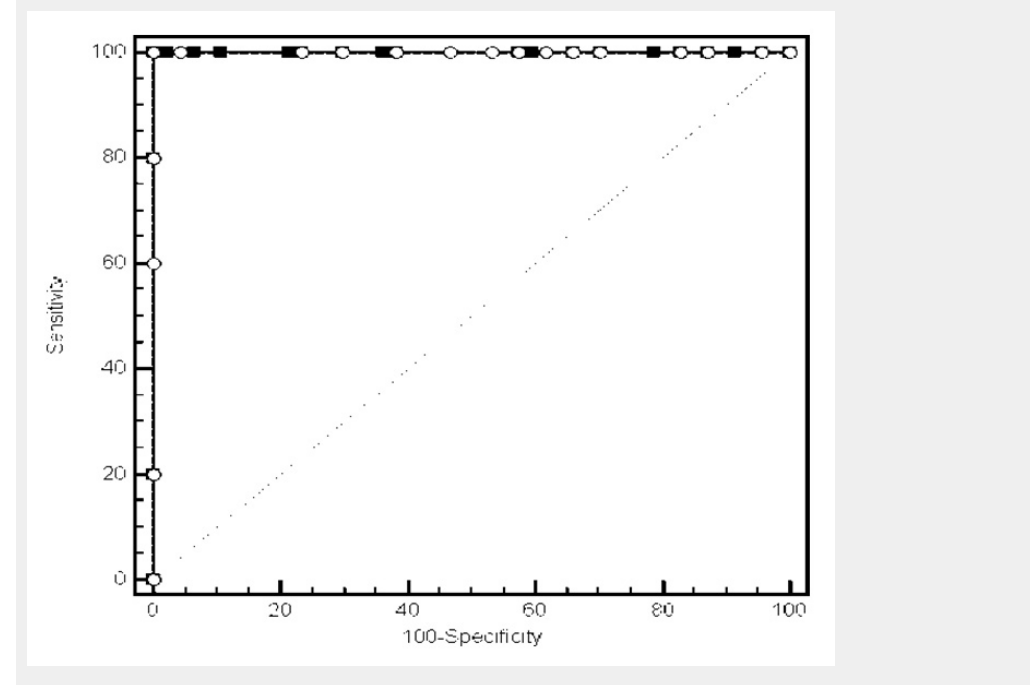
Figure 3 Receiver operating characteristic (ROC) curves for prediction of permanent hypoparathyroidism using intraoperative rapid PTH assay or standard PTH assay taken 24 hours after surgery. Both curves had an area under the curve (AUC) of 1.0 (SE = 0, 95% CI = 0.932 – 1.0, P < 0.001). The two curves were identical (P = 1.0). The optimal cutoff value was a PTH level < 12 pg/ml on the intraoperative PTH curve or < 15 pg/ml on the postoperative PTH curve. Both cutoff values had a sensitivity of 100% (95% CI = 47.8% – 100%), a specificity of 100% (95% CI = 92.5% – 100%), LR– of 0, PPV of 100% (95% CI = 47.8% – 100%), and NPV of 100% (95% CI = 92.5% –